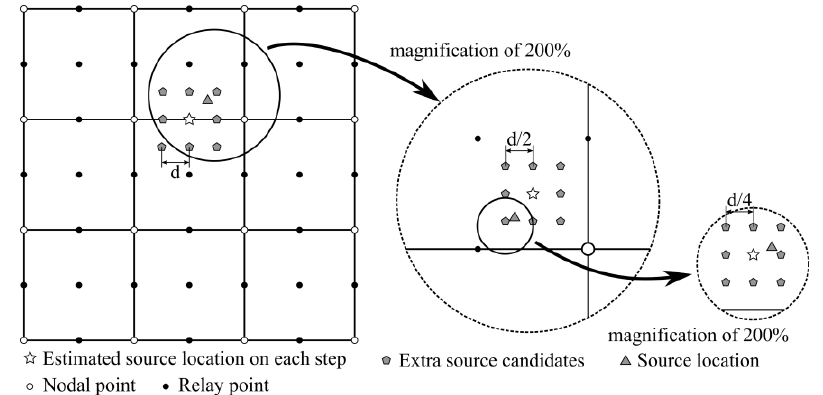
Figure 4. A new source localization